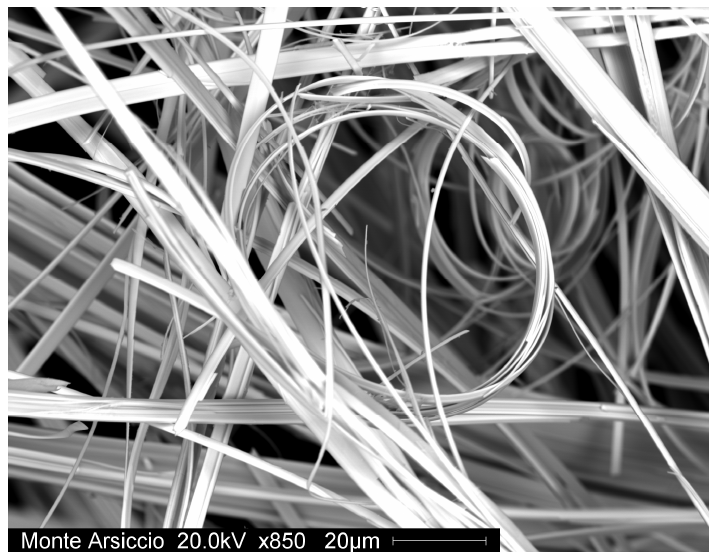
Figure 1. Chovanite, ribbon-like crystals and curls. Sant’Olga level, Monte Arsiccio mine, Apuan Alps, Tuscany, Italy. Tuscany,